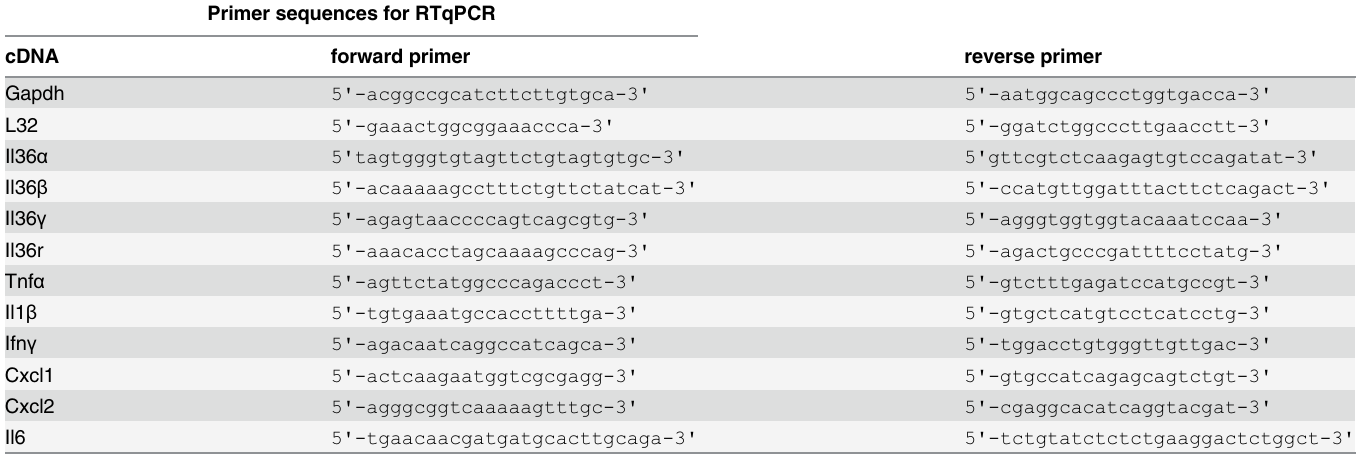
Table 1. Nucleotide sequences of primers used for RT-qPCR. Primer sequences for